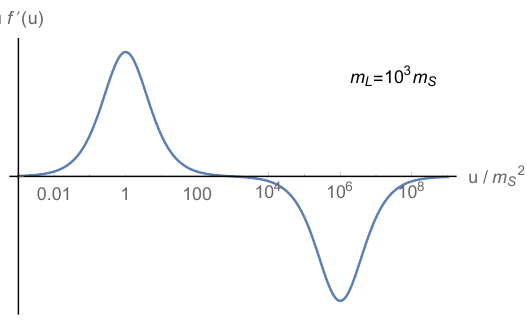
Figure 2 . The leading order loop integrand for ( g − 2) µ . The integral vanishes due to a cancellation between opposite sign contributions around the scales m L , m S of the heavy fermions, as guaranteed by the fact that the integrand is a total derivatve vanising at both zero and infinity. To clarify the structure of the integrand, we take m L = 10 3 m S